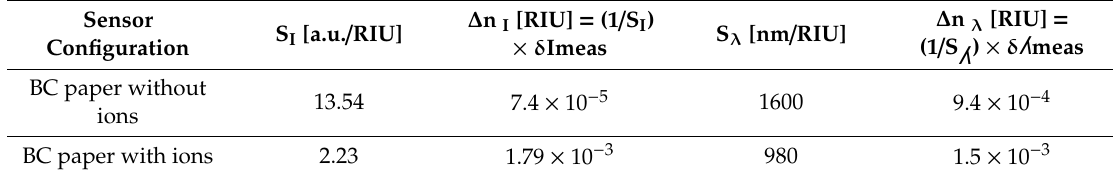
Table 1. Performances comparison for the sensor configurations (with and without ions in BC paper). Figure 2. Outline of the experimental setup used to test the plasmonic Sensor